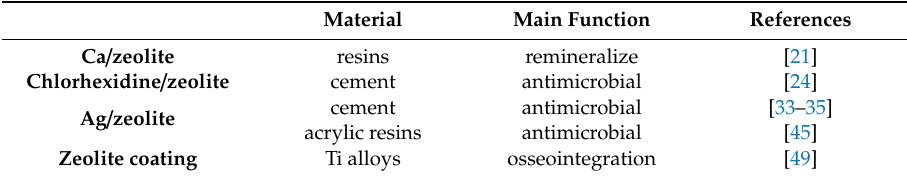
Table 1. Main applications of zeolite-based materials in